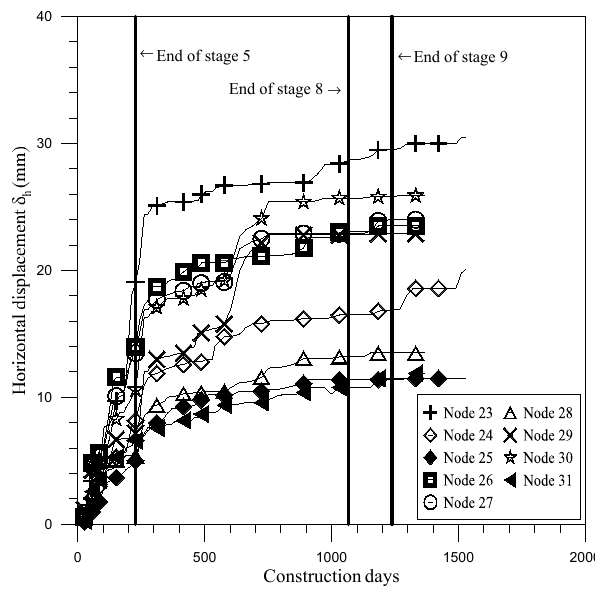
Figure 15. Deflection of points 23–31.